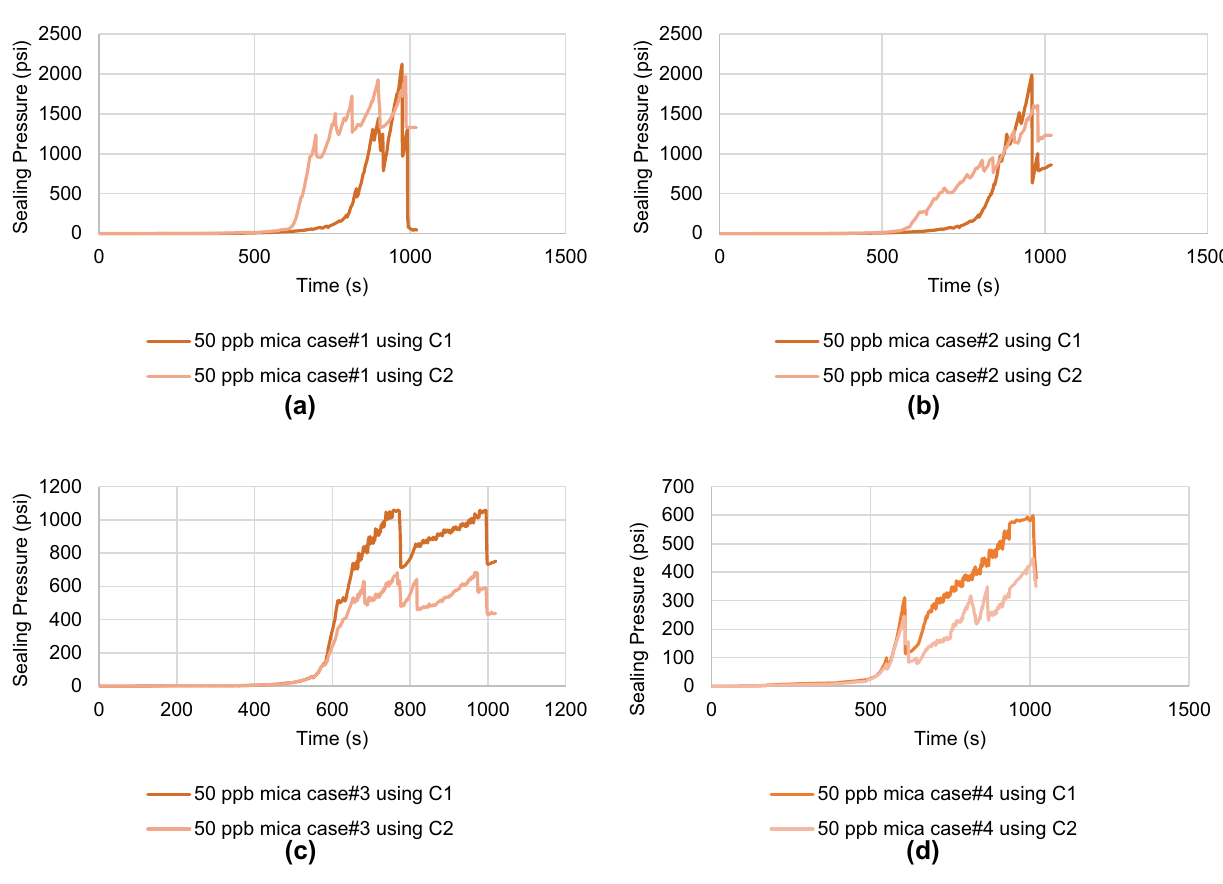
Fig. 11 HPA Pressure versus Time plot for 50 ppb Mica showing maximum sealing pressure at different fracture widths, a case#1, b case#2,